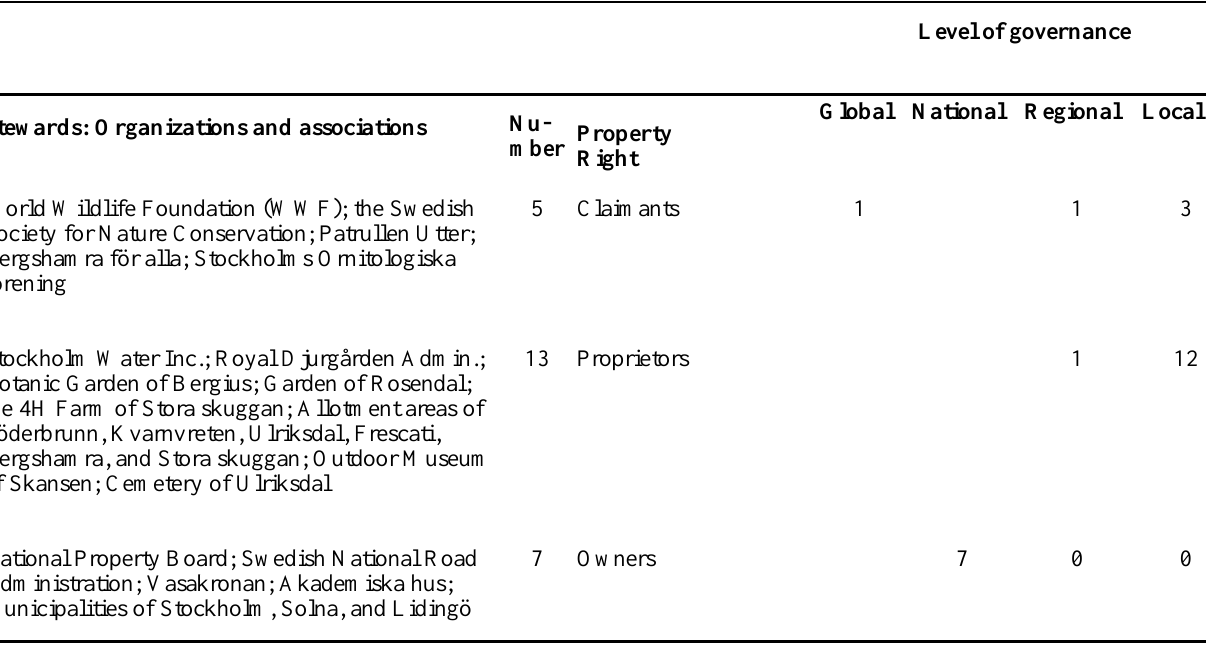
Table 3 . Local stewardship associations involved in the management of the National Urban Park Stewards: Organizations and associations Nu